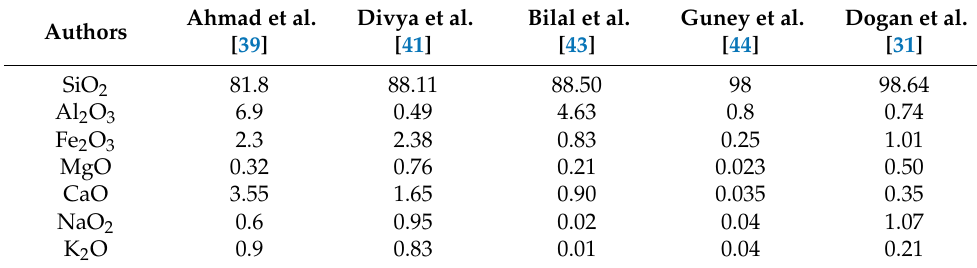
Table 2. Chemical Composition of